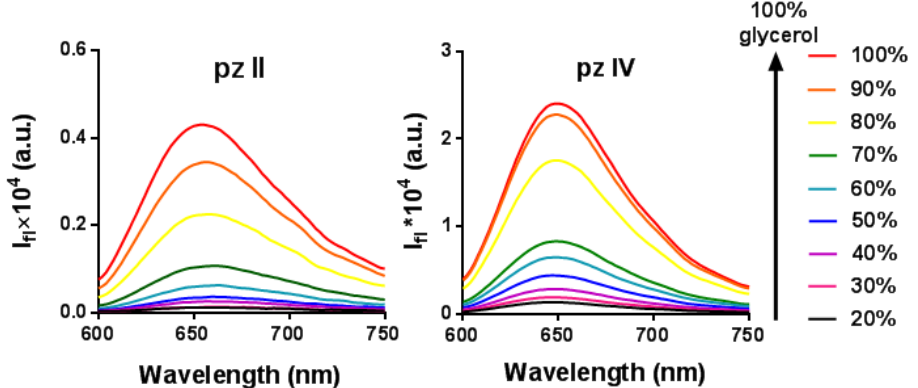
Figure 2. Enhancement of the fluorescence intensity of pz II and pz IV in ethanol – glycerol solutions at room temperature.